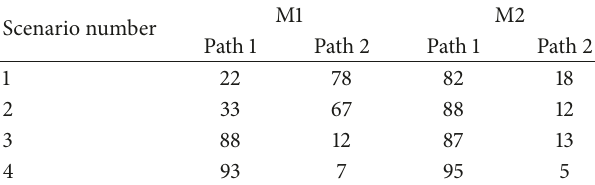
Table 4: Calculated results of M1 and M2